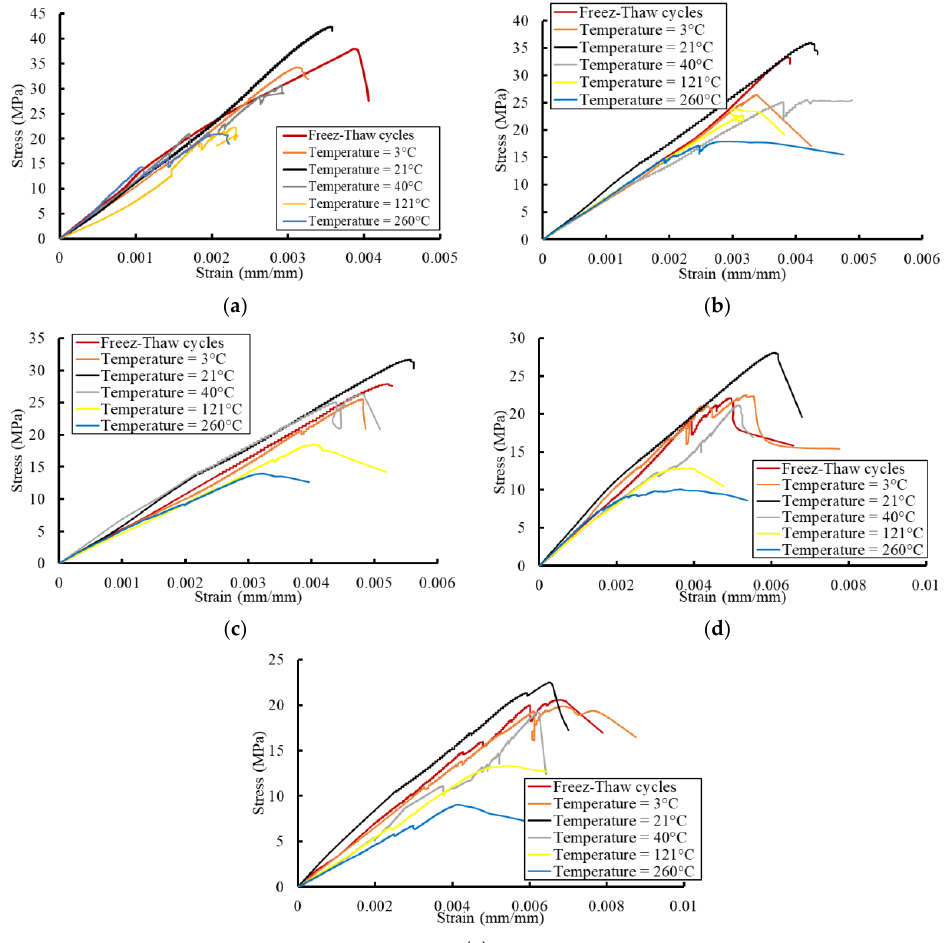
Figure 11. The stress – strain relationships of concrete with CR and exposed to temperatures. ( a ) 0% content of CR. ( b ) 5% content of CR. ( c ) 10% content of CR. ( d ) 15% content of CR. ( e ) 20% content of CR.